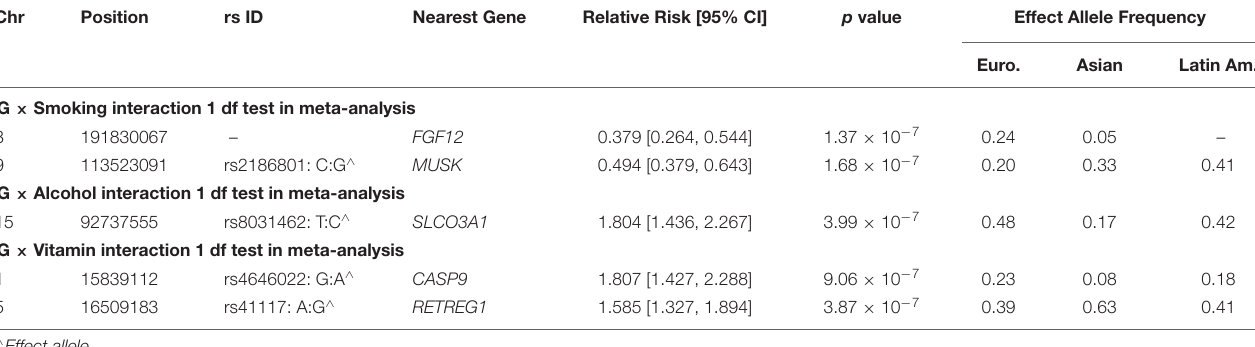
TABLE 2 | Markers exceeding the threshold for “suggestive” evidence ( p < 10 − 6 ) in the 1 df test for G × E interaction from meta-analysis over GENEVA and POFC case–parent trios for all OFC.